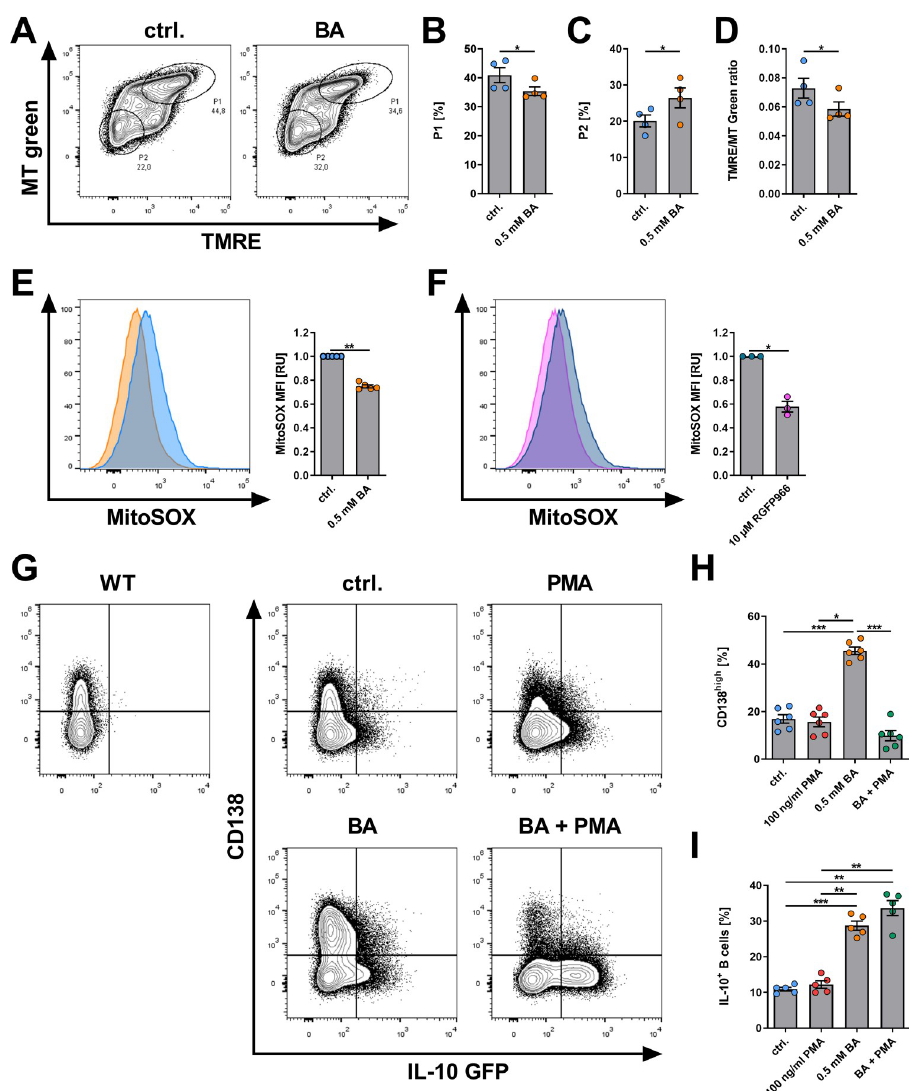
Fig 8. BA decreases mitochondrial membrane potential and superoxide production after one day of cell culture. (A) Representative contour plots of MT-Green/TMRE-stained B cells after incubation with 0.5 mM BA for 1 day. (B) P1 frequencies after incubation with 0.5 mM BA for 1 day indicating MT-Green high TMRE high B cells (n = 4). (C) P2 frequencies after incubation with 0.5 mM BA for 1 day indicating MT-Green low TMRE low B cells (n = 4). (D) Ratio of TMRE MFI and Mito-Green MFI after incubation with 0.5 mM BA for 1 day indicating MT-Green low TMRE low B cells (n = 4). (E) Incubation with 0.5 mM BA for 1 day decreased the levels of mitochondrial superoxide levels indicated by MitoSOX staining (n = 5). (F) Incubation with 10 μ M RGFP966 for 1 day decreased the levels of mitochondrial superoxide levels indicated by MitoSOX staining (n = 3). (G) Representative contour plots of CD138 and IL-10 GFP expression in isolated splenic B cells from IL-10 reporter mice after treatment with 0.5 mM BA and/or 100ng/ml PMA. (H) Frequencies of CD138 high PCs after treatment of isolated murine B cells with 0.5 mM BA and/or 100ng/ml PMA after 4 days of cell culture (n = 6). (I) Frequencies of IL-10 + B cells after treatment of isolated murine B cells with 0.5 mM BA and/or 100ng/ml PMA after 4 days of cell culture (n = 5). PMA = Phorbol-12-myristate-13-acetate. � p < 0.050, �� p < 0.010, ��� p <